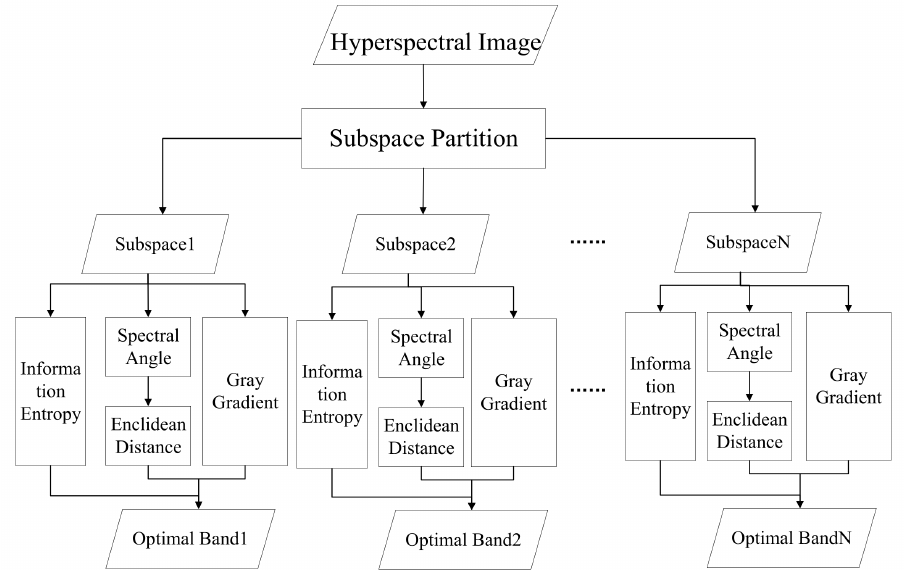
Figure 1. Flowchart of